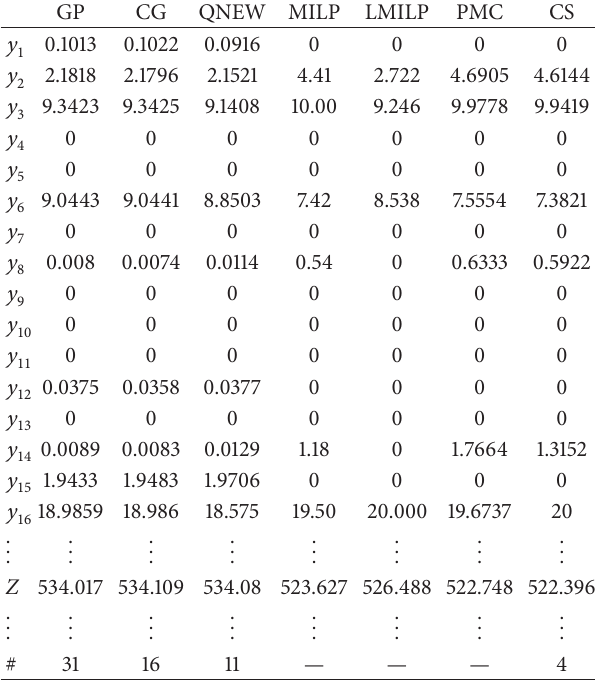
Table 5: Comparison of results from solving the 16-link network for scenario 2.